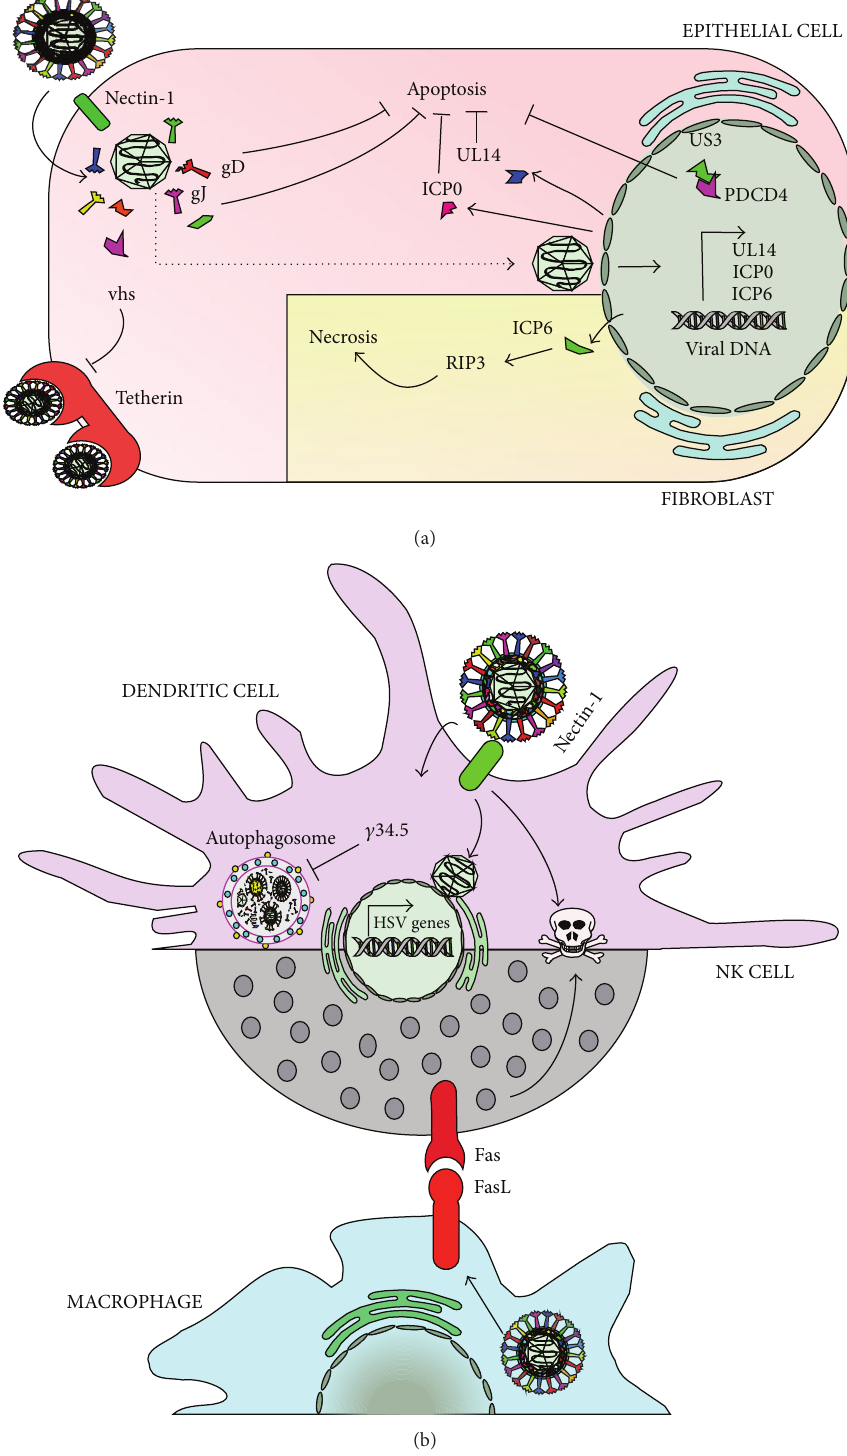
Figure 2: HSVs interfere with cell viability. HSVs encode determinants that modulate cell viability. (a) Within epithelial cells, HSV can extend thesurvivalofcellsbyblockingapoptosisthankstoviralproteins,suchasgD,gJ,UL14,ICP0,andUS3.Tetherin,ahostantiviralfactorinvolved in blocking virus release from the surface of infected cells, is blocked by HSV vhs. Contrarily, fibroblasts display necrosis upon infection with HSV, which would be mediated by ICP6. (b) Dendritic cells display apoptosis early after infection with HSVs by unknown viral determinants. The autophagosome, which mediates virus control in these and other cells, such as neurons, is inhibited by the viral protein 𝛾 34.5. HSV also induces apoptosis of NK cells, albeit through Fas/FasL interactions between these cells and HSV-infected